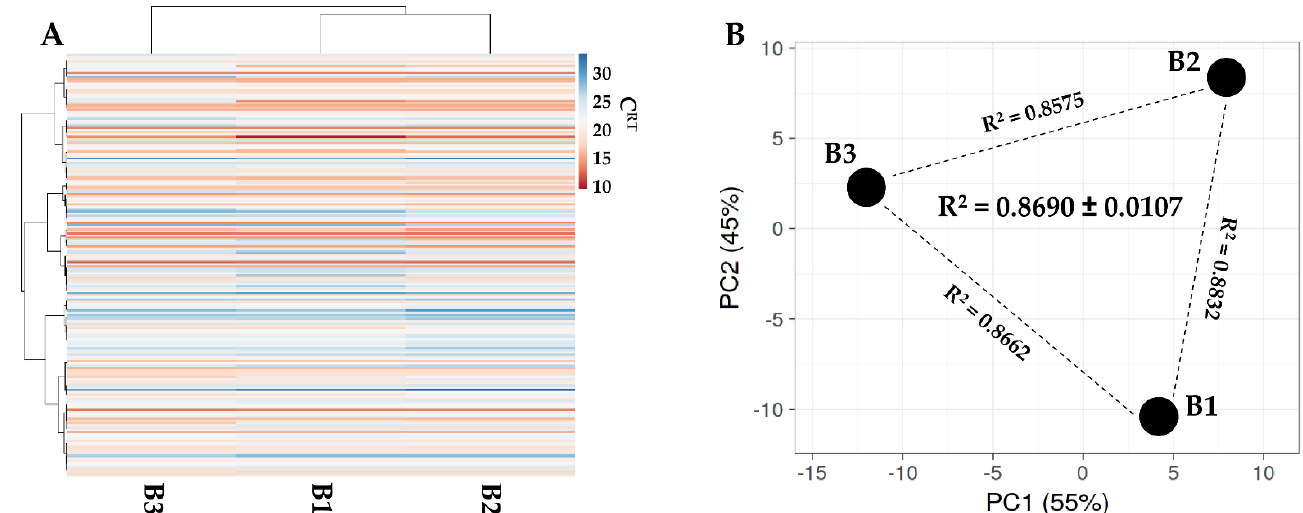
Figure 6. Comparison of EV-miRNA expression profiles between SF-treated BMSCs under study. ( A ), heat map of hierarchical clustering analysis of the normalized C RT values of detected miRNAs with sample clustering tree at the top. The color scale reflects the absolute expression levels: red shades = high expression levels (low C RT values) and blue shades = low expression levels (high C RT values). B1, B2 and B3 stands for BMSC donors 1, 2 and 3. ( B ), principal component analysis of the normalized C RT values of detected miRNAs. X and Y axis show principal component 1 and principal component 2 that explain 55% and 45% of the total variance. B1, B2 and B3 stands for BMSC donors 1, 2 and 3. Table 3. miRNAs detected in SF-treated BMSC-EVs and falling in the first quartile of expression. miRBase ID